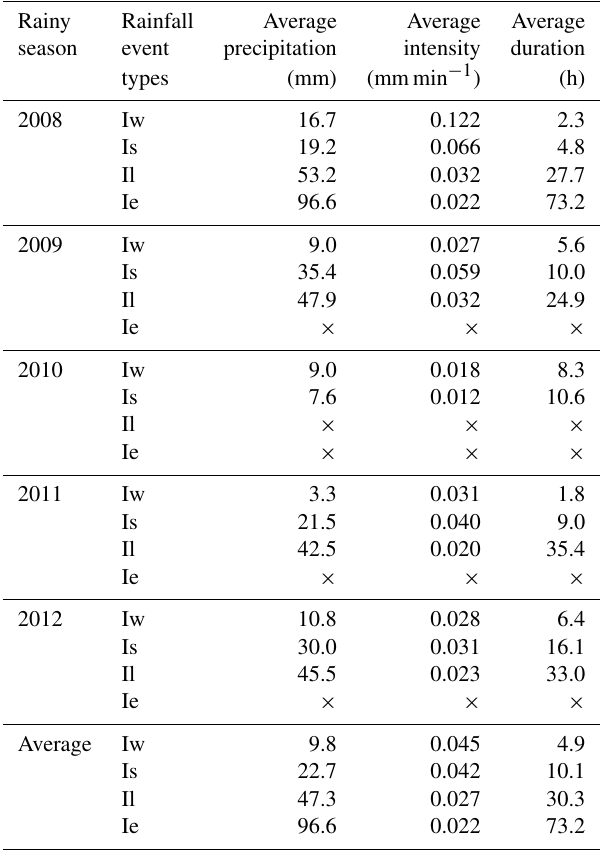
Table 3. Main characteristics of the four types of random rainfall event over five rainy